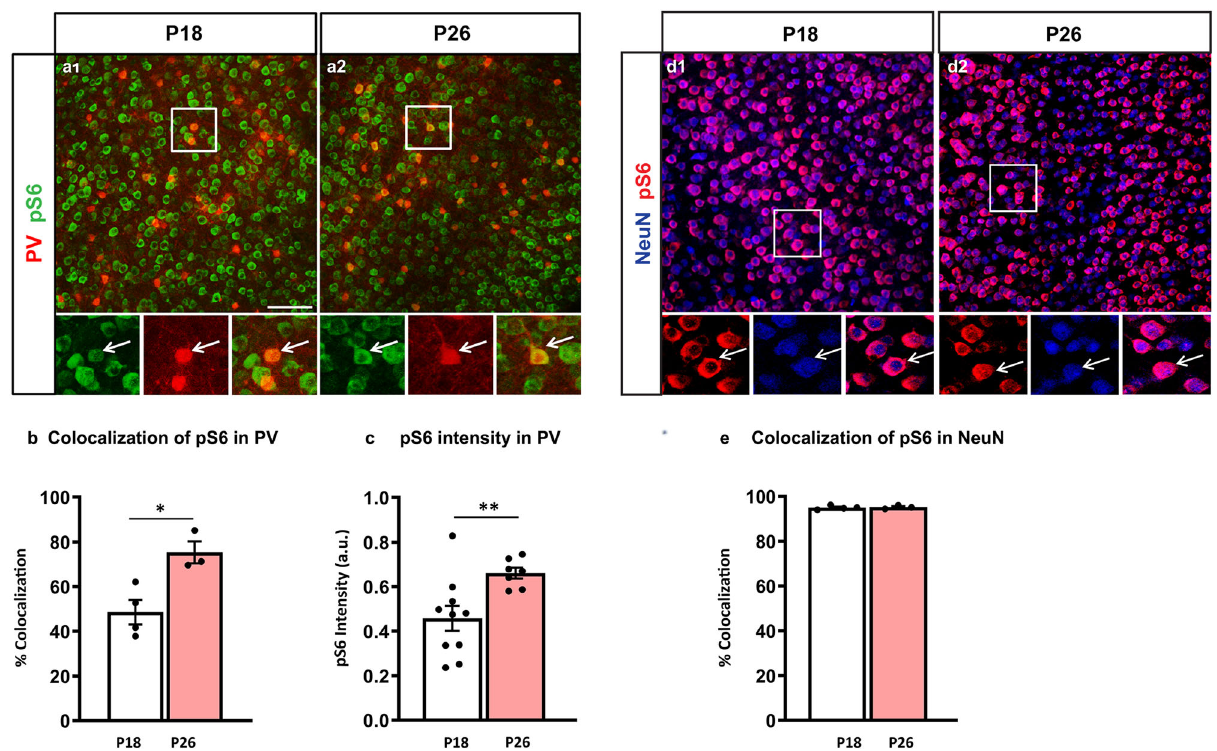
Fig. 1 pS6 expression levels increase speci fi cally in PV cells between the second and fourth postnatal weeks. a Coronal sections of mouse somatosensory cortex immunostained for pS6 (green) and PV (red) at P18 ( a1 ) and P26 ( a2 ). b Number of PV cells expressing detectable levels of pS6 increases during the second to fourth postnatal week (Welch ’ s t -test, * p = 0.0152). Number of mice; P18, n = 4; P26, n = 3. c Mean pS6 intensity in individual PV cells is signi fi cantly higher at P26 than at P18 (Welch ’ s t -test, ** p = 0.0061). Number of mice; P18, n = 10; P26 n = 7. d Coronal sections of mouse somatosensory cortex immunostained for pS6 (red) and NeuN (blue) at P18 ( d1 ) and P26 ( d2 ). e Percentage of colocalization of pS6 and NeuN is not signi fi cantly different between the two developmental ages (Welch ’ s t -test, p = 0.7663). Number of mice; P18, n = 4; P26, n = 3. Scale bars in a1 - a2 , d1 - d2 , 75 µ m. Data represent mean ± SEM. Source data are provided as a Source Data fi